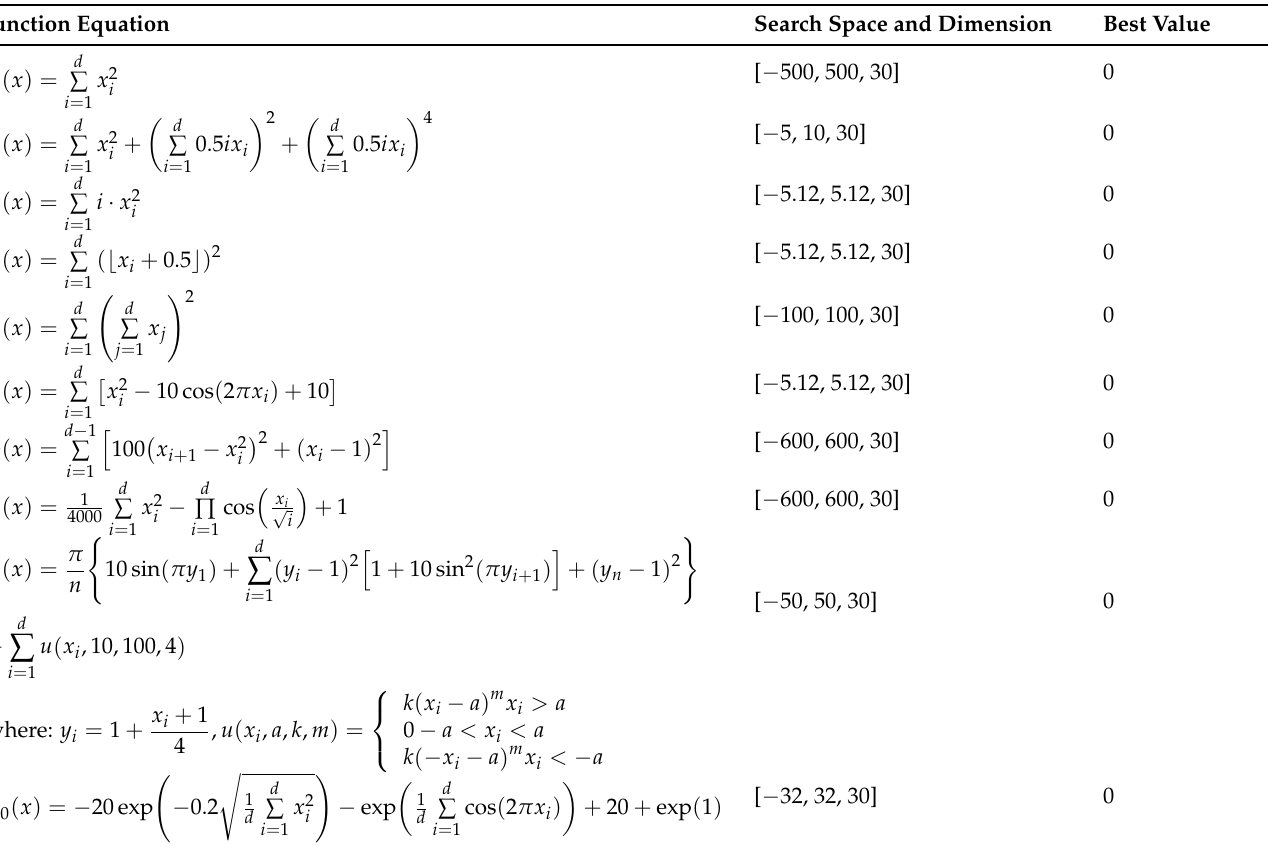
Table 1. Benchmark